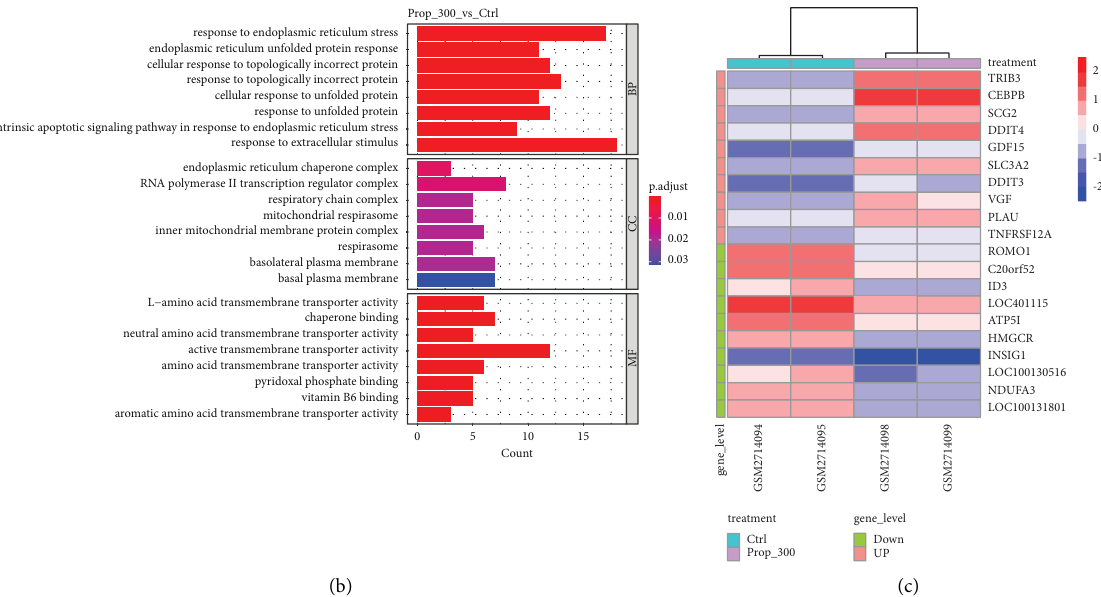
Figure 4: Bioinformatic analysis showed that propofol treatment led to endoplasmic reticulum stress. Transcriptional data of GSE101724 were downloaded from the GEO database and diferentially expressed genes after propofol (300 μ M) treatment were functionally analysed. Diferentially expressed genes were shown in the volcano plot (a) with up- and downregulated genes labelled as red or blue, respectively. GO functional enrichment of the diferential expressed genes showed enrichment in the endoplasmic reticulum stress-related pathways (b). Te top 10 up- or downregulated genes after propofol treatment were plotted as the heatmap (c).